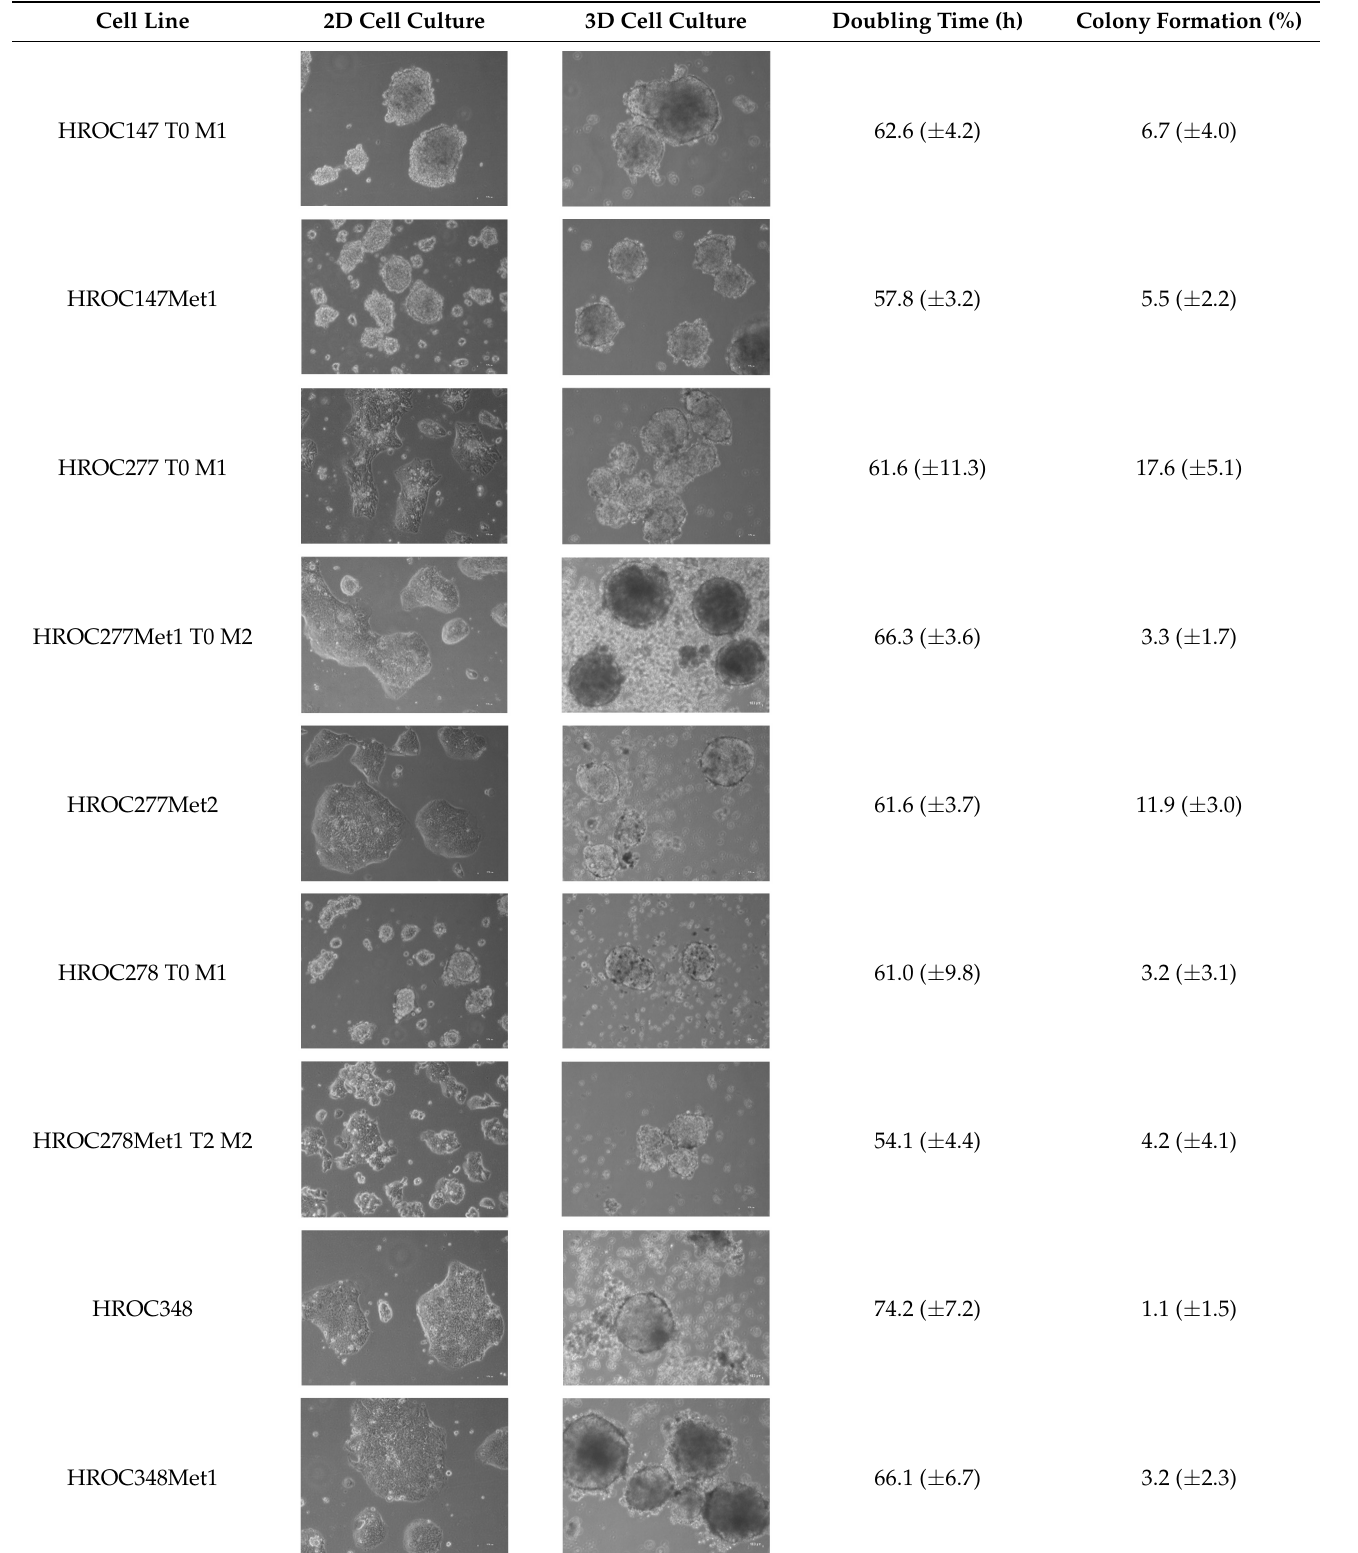
Table 2. Cell Line Characterisation. Pictures were taken at 10 × magnification with a light